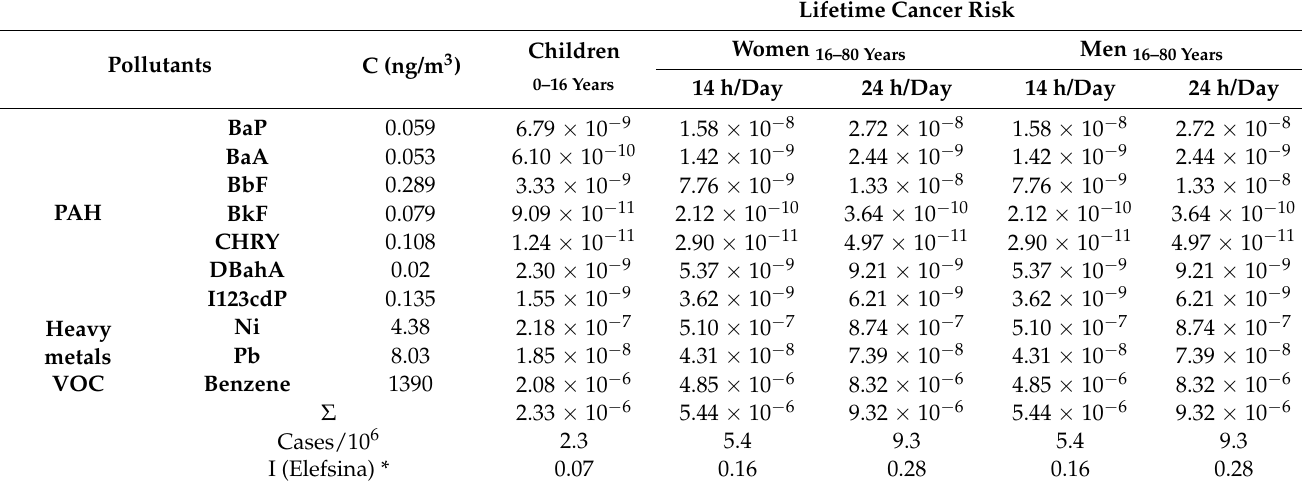
Table A8. Cancer risk assessment B.III method (Chalvatzaki, 2019).